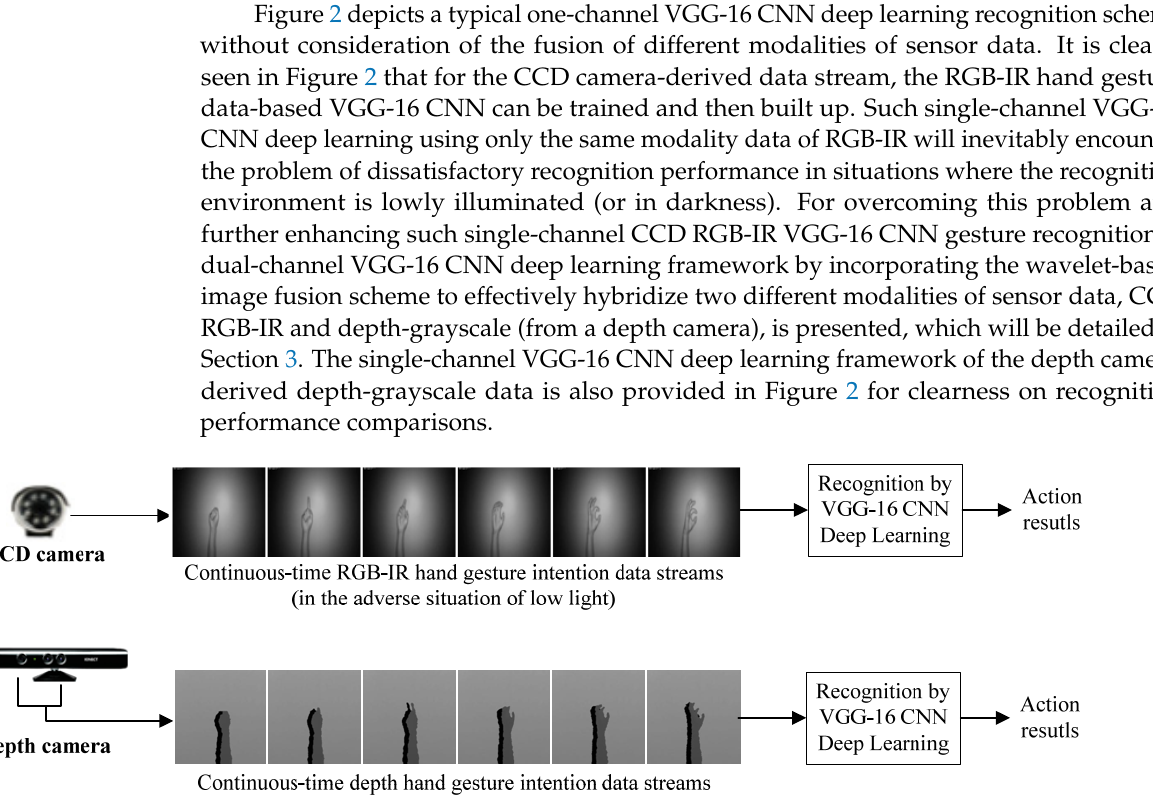
Figure 2. The typical VGG-16 CNN deep learning recognition framework with only one modality channel to process the same type of sensor data (the CCD RGB-IR modality or the depth camera-derived depth-grayscale modality in an environment of low illumination).